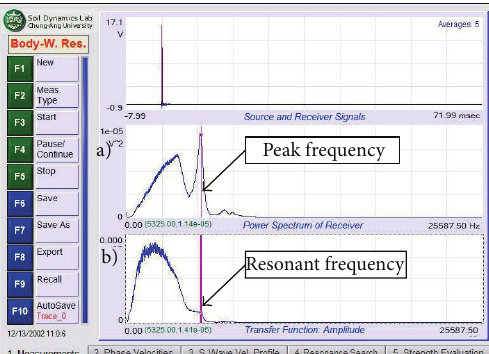
Figure 10: Frequencies generated at (a) power spectrum receiver and (b) transfer function (obtain resonant frequency to determine thickness of asphalt surface layer).